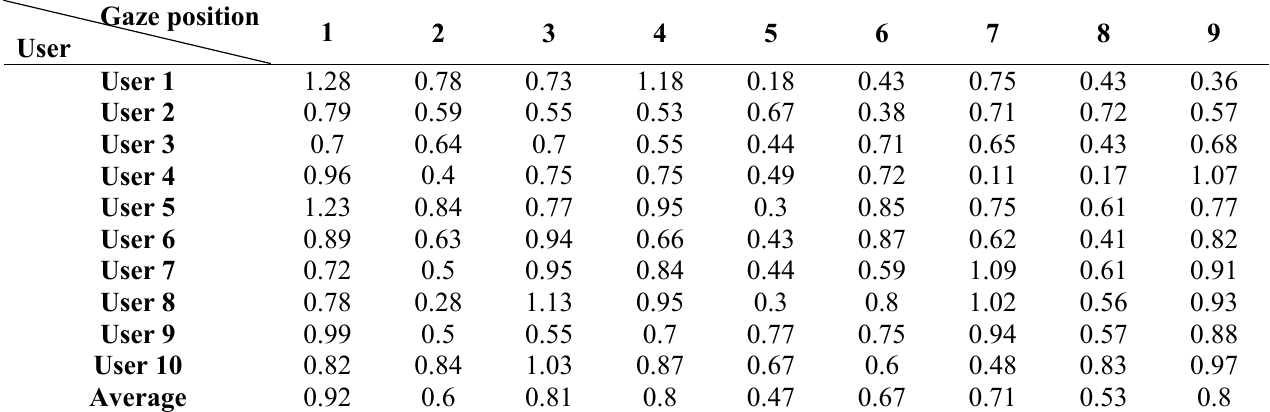
Table 6. The gaze detection errors for each of the nine reference points when the users were wearing glasses (units: °).